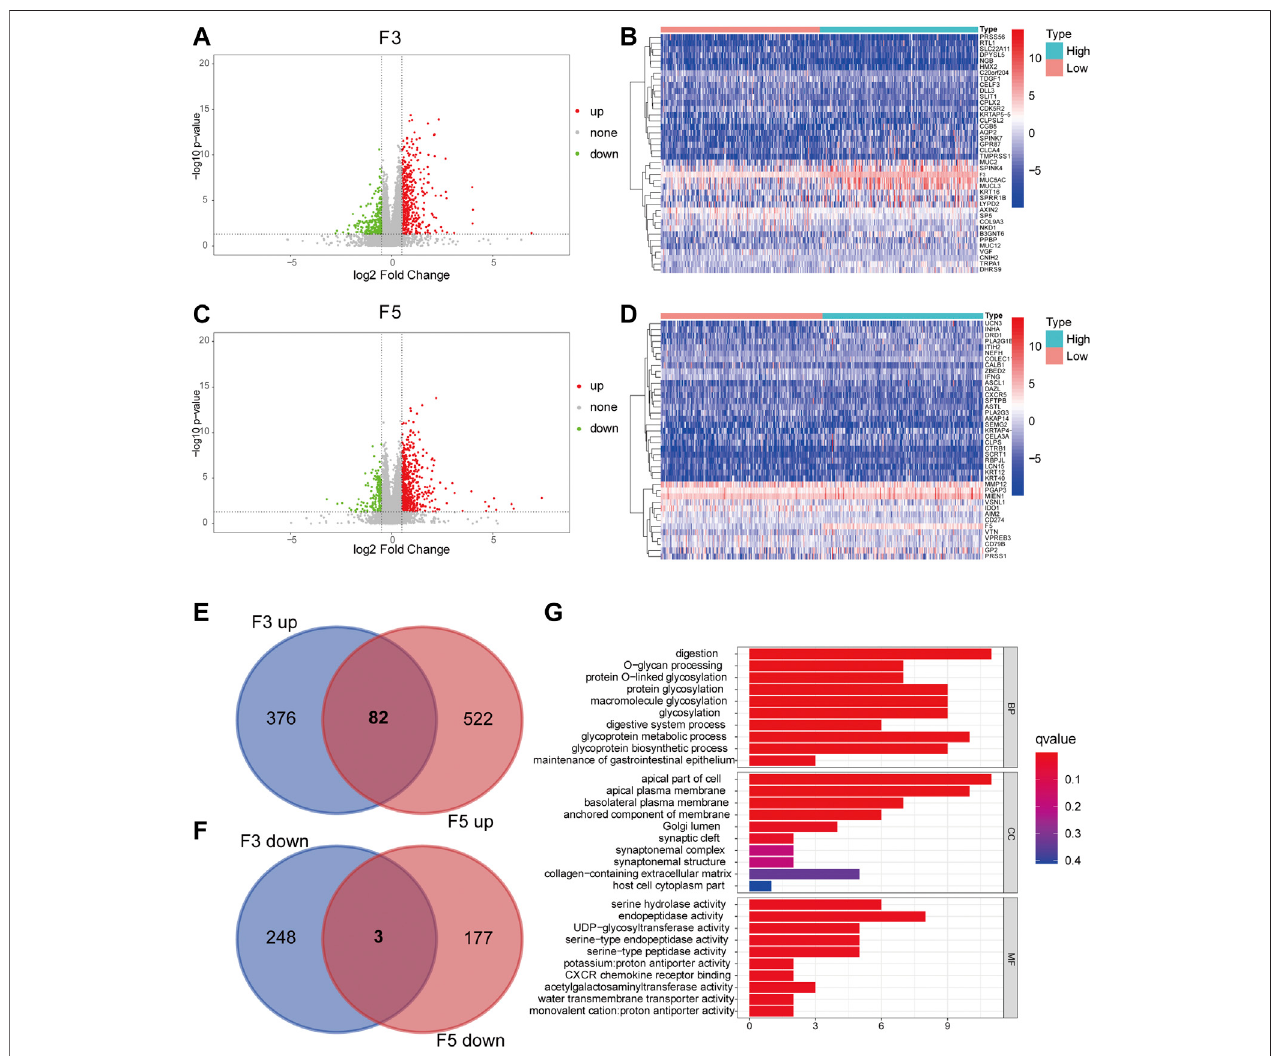
FIGURE 8 | GO enrichment of overlapping DEGs. (A) Volcano plot of the DEGs of F3 (high and low). p < 0.05 was the cutoff criterion for DEG signi fi cance, and an absolute value of log 2 -fold change > 0.5 was considered signi fi cant. The red dots represent genes that are upregulated, the green dots represent genes that are downregulated, and the black dots resemble genes that are nonsigni fi cant. (B) Heatmap depicting the top 20 upregulated and downregulated genes with F3 high and low expression. A higher fold change is depicted with a redder color. (C) Volcano plot of the DEGs of F3 (high and low expression), similar to (A) . (D) Heatmap depicting the top 20 upregulated and downregulated genes with F5 high and low expression, similar to (B) . (E – F) Venn plot displaying the overlapping genes of F3 and F5. (G) GO plot illustrating different enriched pathways of overlapping